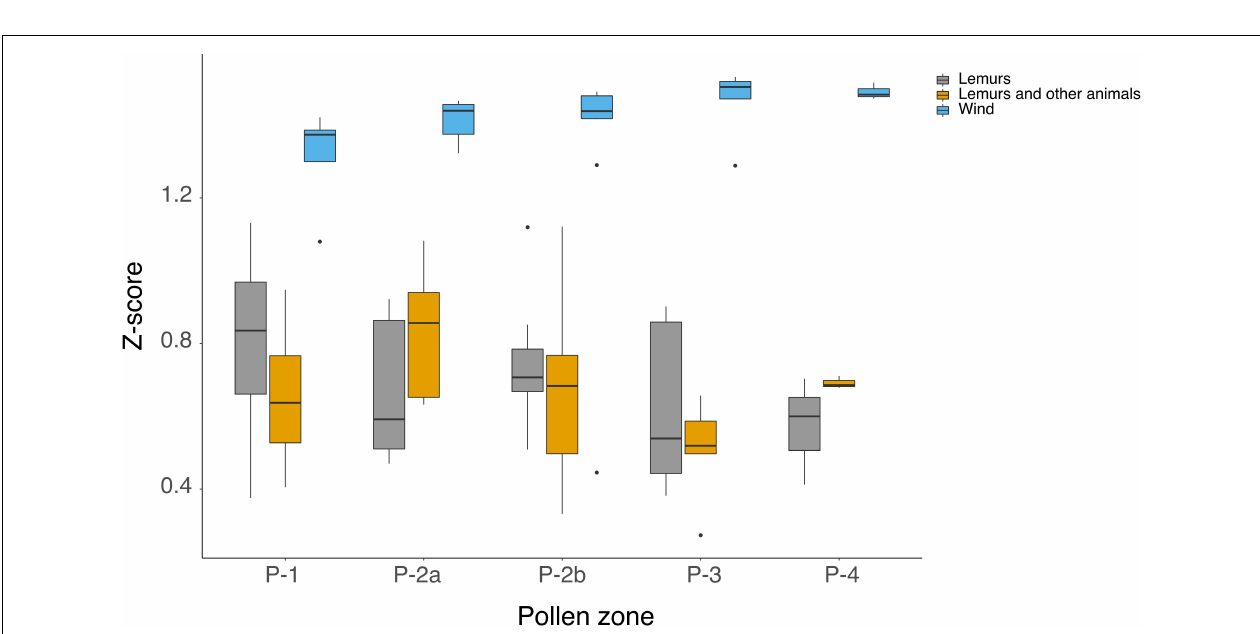
FIGURE 6 | Box-and-whisker plots of the normalized abundances (z-score) for pollen types, distinguished by seed dispersal mechanism, in the sediment core from Namonte, southwest Madagascar.